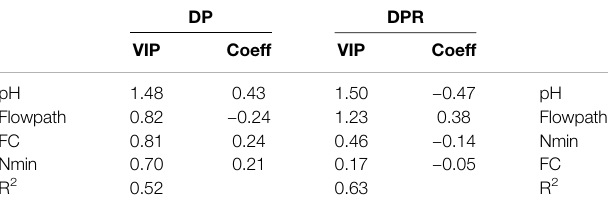
TABLE 4 | PLS model regression parameters and results for the prediction of DP and DP [ (cid:2) N 2 O/(N 2 +N 2 O)]. All samples were taken into account ( n (cid:2) 104). VIP (variable importance in prediction), coeff (coef fi cient) de fi ning the direction of in fl uence on the responding variable. DP was log-normalized prior to